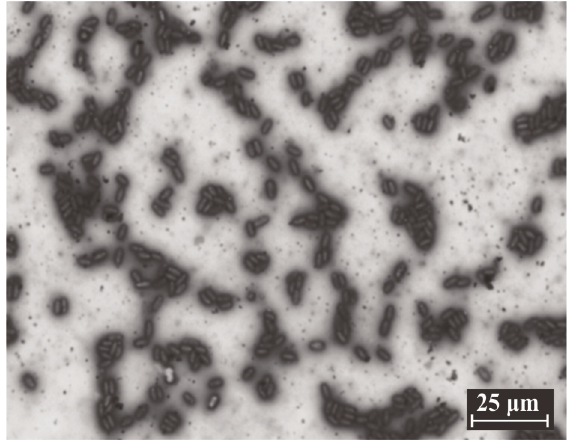
Figure 1 - Image of the smear stained with giemsa. Spores of the Clado Nosema/Vairimorpha isolated from the intestinal contents of D. saccharalis viewed under a phase contrast microscope (1000x). Scale bar = 25